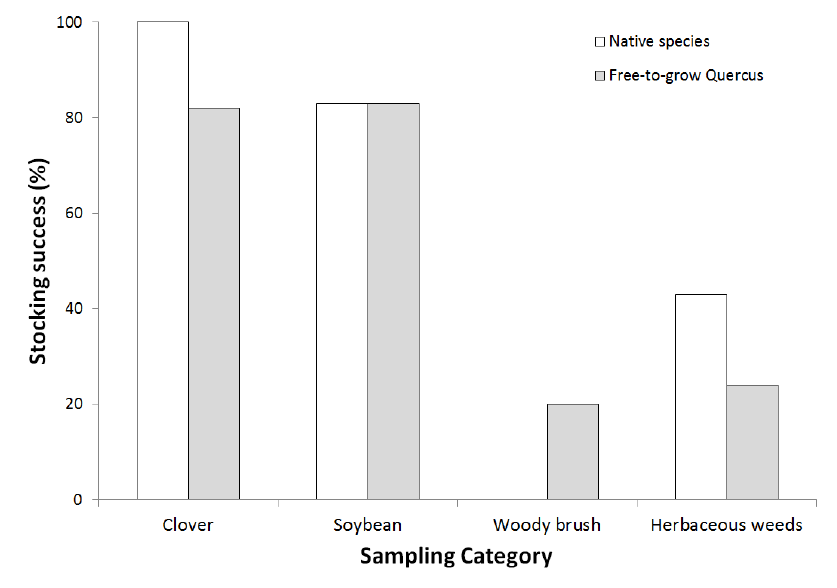
Figure 3. Stocking (%) success for all native tree species and free-to-grow Quercus stems by Land Cover Type